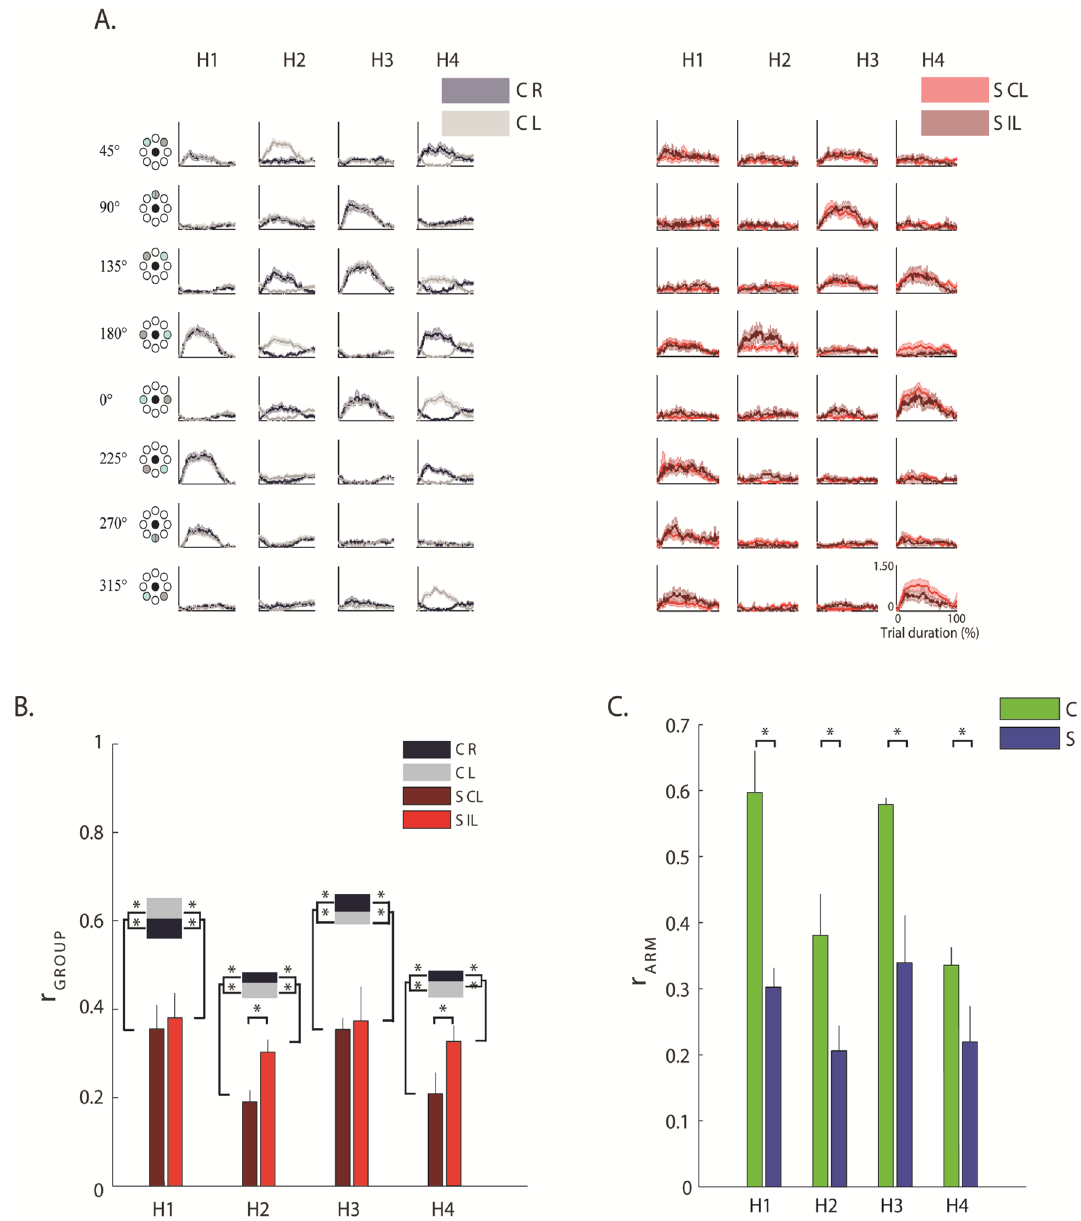
Figure 6. Activation coefficients of the muscle synergies. ( A ) The grey and red line represents the mean activation profiles of the four synergies (H1 to H4) for control subjects (C, on the left) and stroke subjects (S, on the right), respectively. Activation coefficients were computed considering all trials, i.e., including all directions and repetitions. Darker and brighter colors represent the right (R) and left (L) arm of C and contralesional (CL) and ipsilesional (IL) arm of S. The shaded area indicates the standard error. ( B ) Comparison between groups (i.e., between stroke and control subjects) by Pearson correlation (r) of the activation profile coefficients of the muscle synergies (r INTER-GROUP ). For the activation coefficient of each synergy, H1 to H4, darker and lighter red bars indicated the values obtained by comparing respectively the contralesional (CL) and ipsilesional (IL) arm of each stroke subject with the corresponding arm of his/her control subject, then averaging across the stroke group. The grey and black horizontal bars indicate the values obtained by comparing respectively the activation profiles of the muscle synergies for left (L) and the right (R) arm of one control subject with the corresponding arm of all the other controls, and then averaging across the control group (r INTRA-GROUP ). The error bars correspond to the standard error. ( C ) Comparison between the two arms of each subject by Pearson correlation (r) of the activation profile coefficients of the muscle synergies (r ARM ). For the activation coefficients of each synergy, H1 to H4, blue bars indicated the average value obtained for the stroke subjects (S) and the green bars the average values obtained for the control subjects (C). The error bars correspond to the standard error. Panel B&C: * indicates significant differences between stroke and control